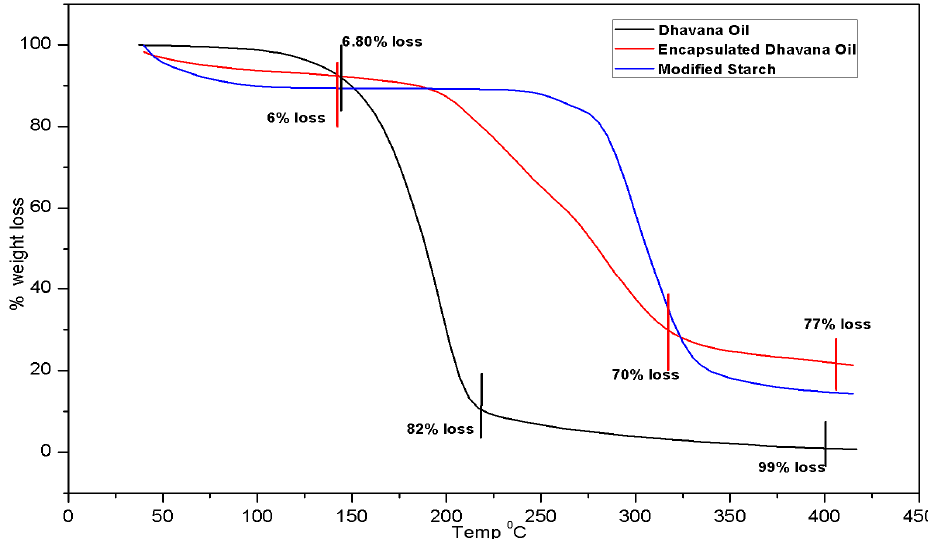
Figure 2. TGA analysis of the neat and encapsulated Dhavana oil.